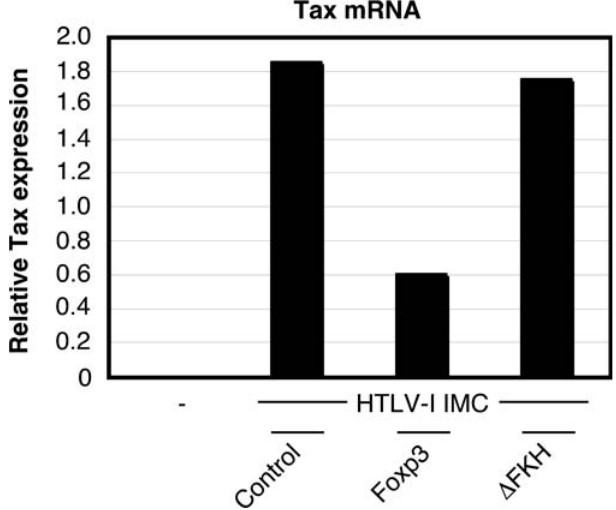
Figure 5. Foxp3 Inhibits the Expression of HTLV-I Tax Directed from an Infectious Molecular Clone HEK 293T cells (5 3 10 5 ) were seeded into six-well plates 1 d prior to transfection in the absence or presence of an HTLV-I infectious molecular clone (pACH; 800 ng) and either a control (EGFP), Foxp3, or D FKH expression vector (800 ng). Expression of HTLV-I Tax from the molecular clone was measured by quantitative RT-PCR (TaqMan). DOI: